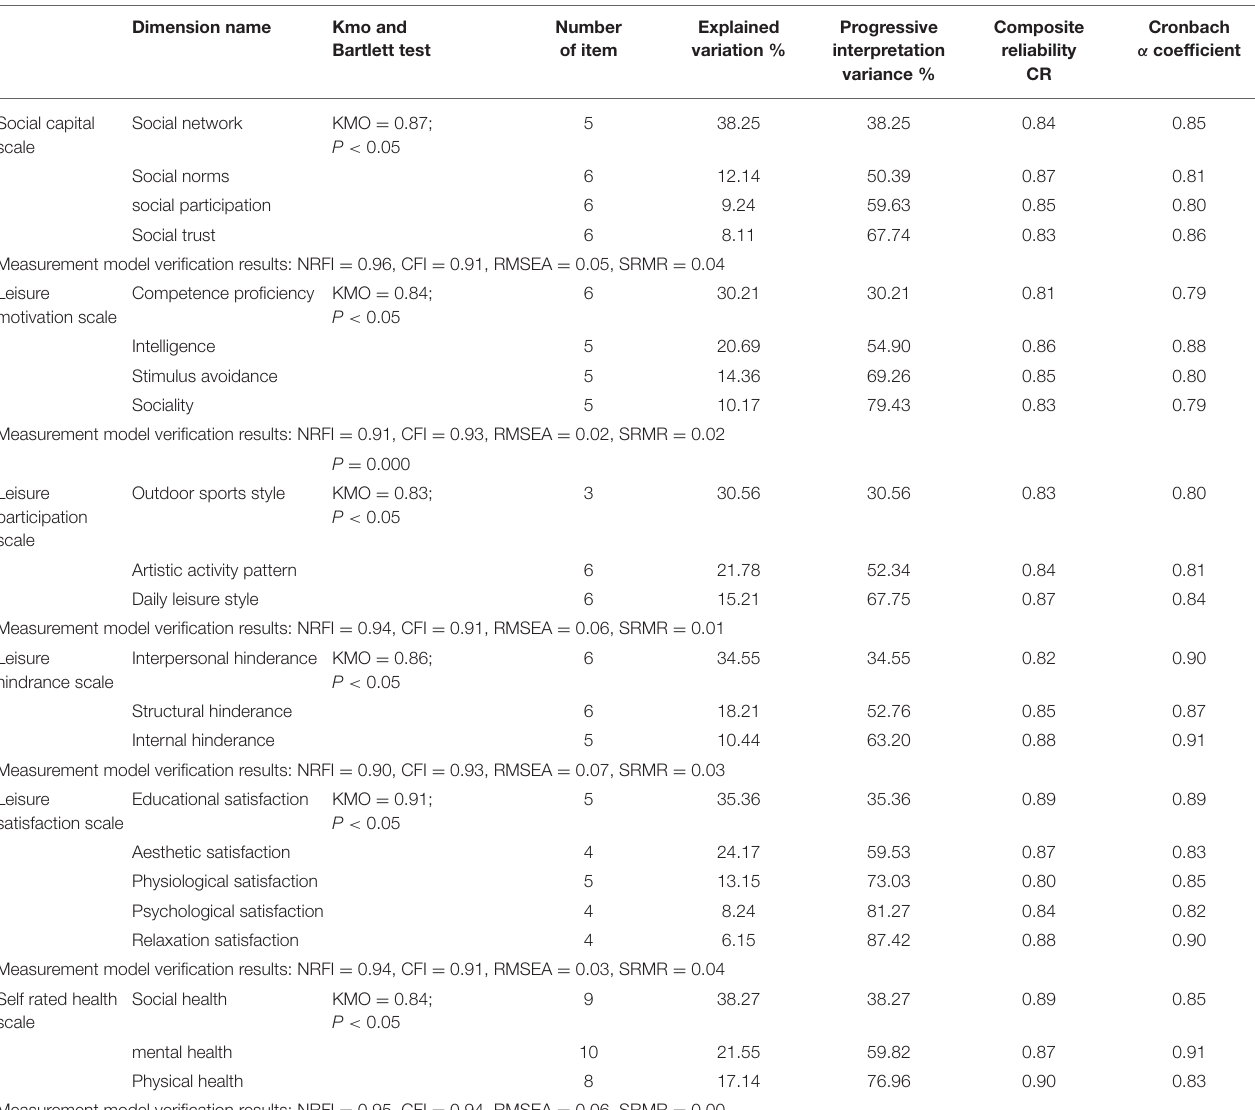
Dimension name Kmo and